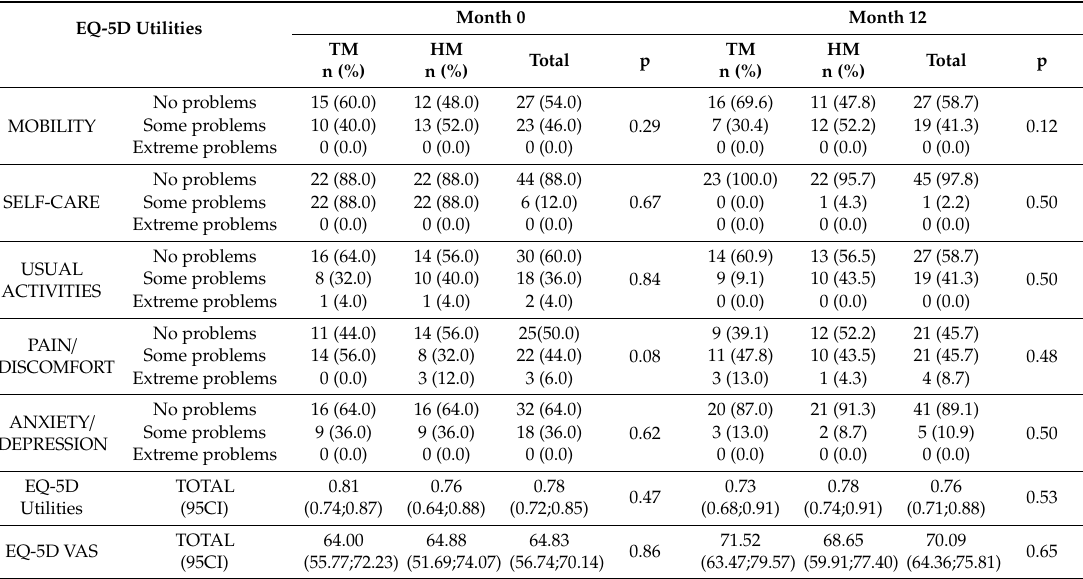
Table 1. Health-related quality of life at 12 months of